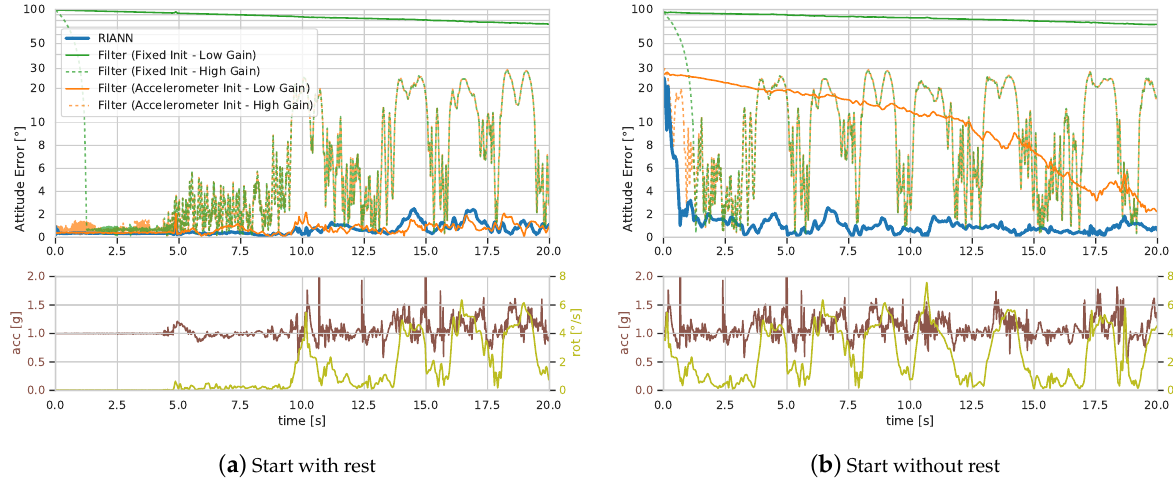
Figure 11. Attitude error of Filter-A and RIANN in the first 20 s of a sequence starting with rest ( a ) or without rest ( b ) with an unknown attitude. Filters exhibit a trade-off between taking a long time converging to a low error and having a larger error over the complete sequence . In sequence ( a ), which starts with rest, only one filter configuration provides good results. In sequence ( b ), which starts without rest, there is no good performing filter configuration, whereas RIANN performs similarly well as in sequence ( a